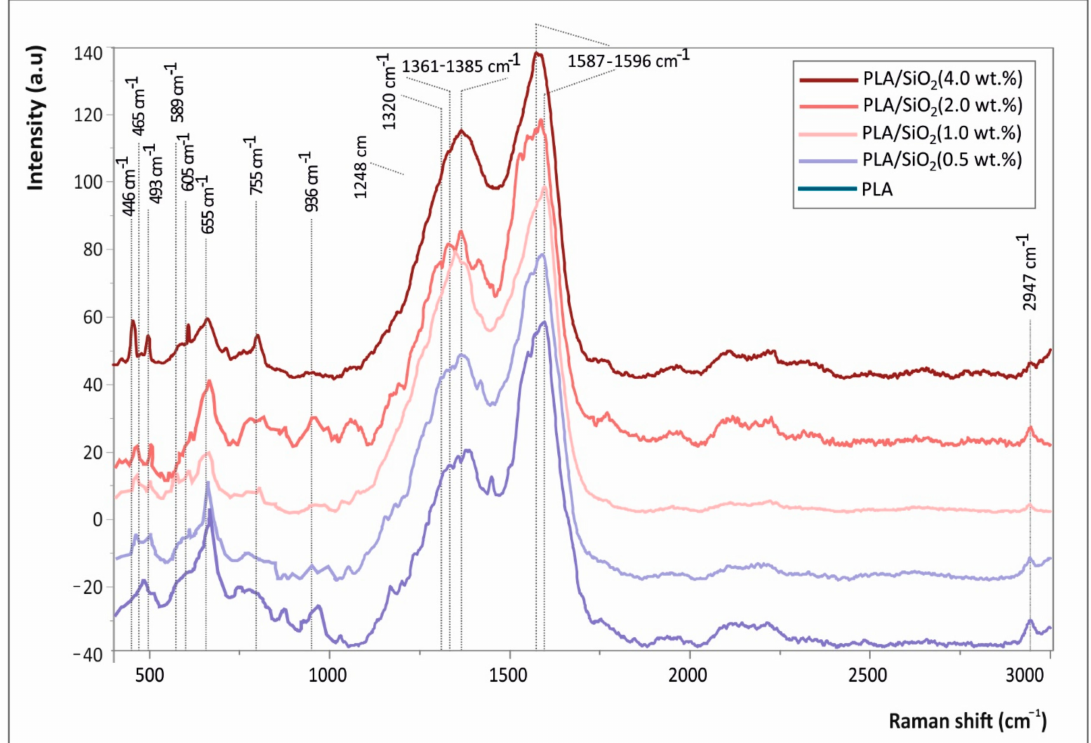
Figure 7. Raman spectra of pure PLA, as well as PLA/SiO 2 nanocomposites at 0.5, 1.0, 2.0 and 4.0 wt.%